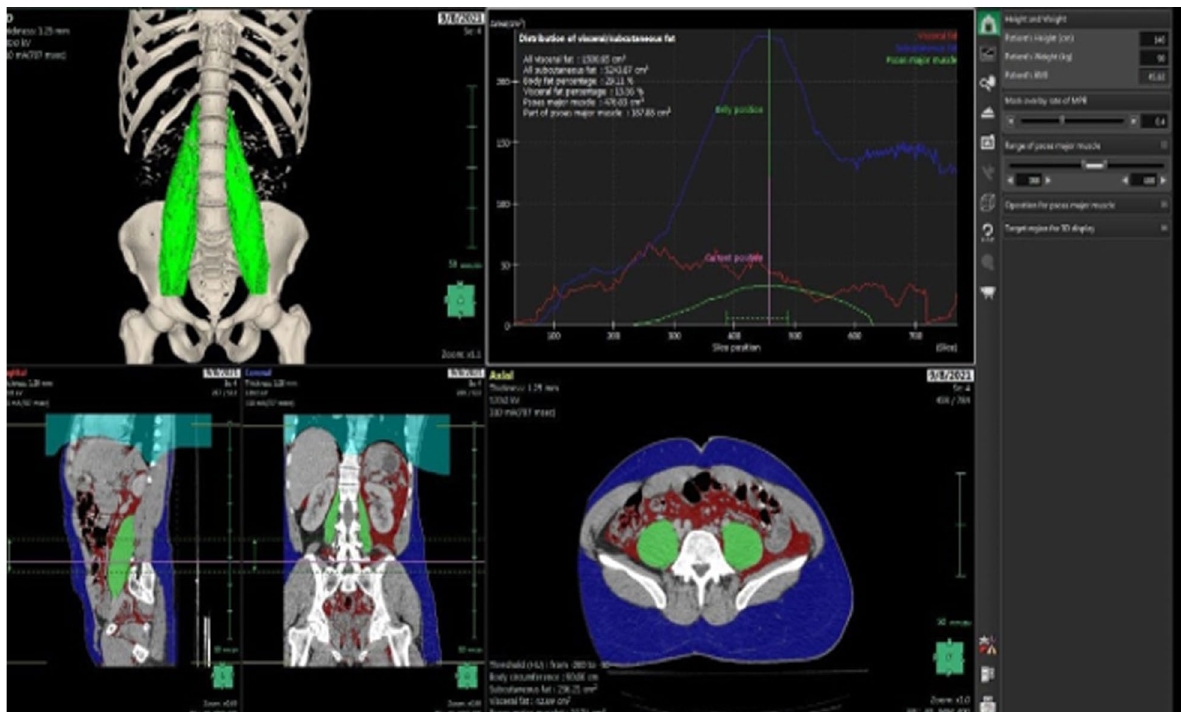
Fig. 3 Psoas muscle volume. Both psoas muscles are shown in green